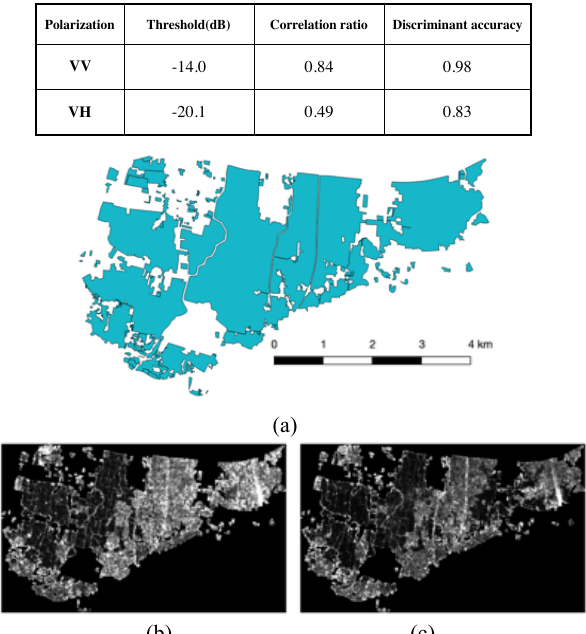
Figure 5. Figure 6. Gamma-naught images after applying rice paddy field mask. (a) rice paddy field mask, (b) Feb.17,2018, and (c) Mar.1, 2018.